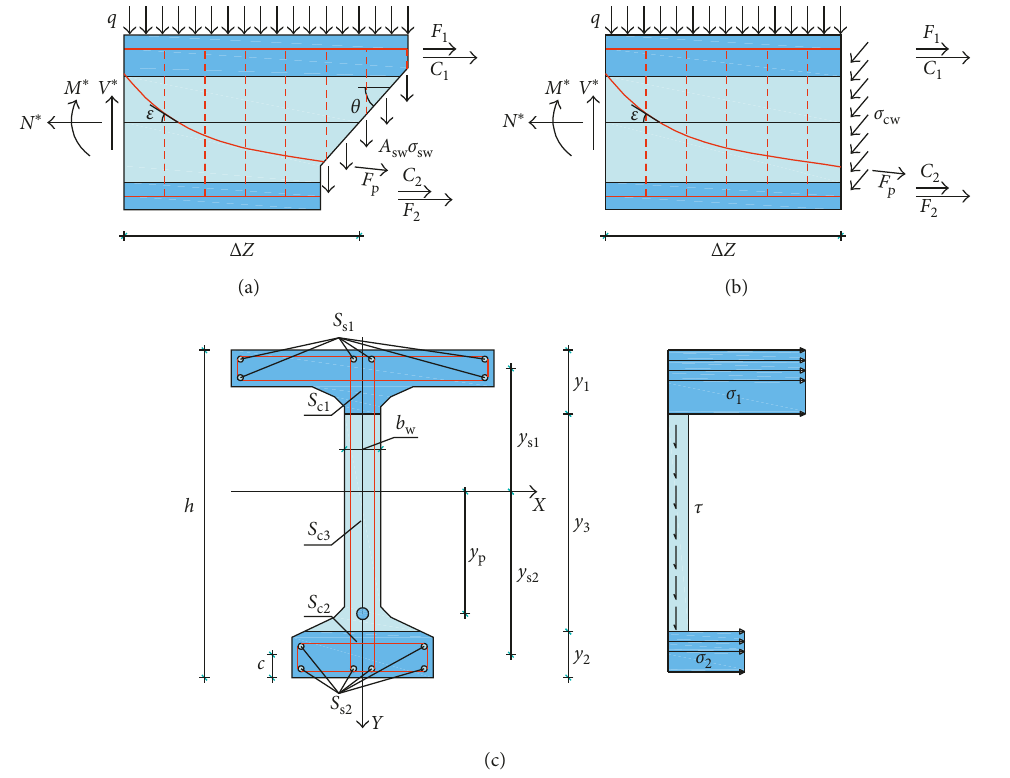
Figure 1: (a, b) External and internal forces scheme assumed; (c) cross-sectional model of the